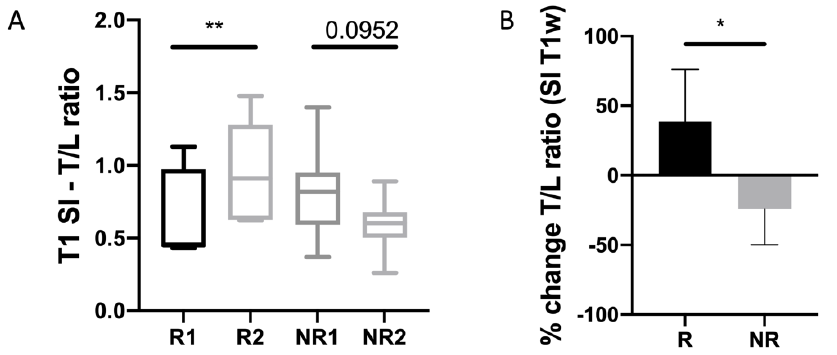
Figure 6. ( A ) T/L ratio of non-enhanced T1w of NELM on baseline and first FU. ( B ) Percentual change of T/L ratio. Asterisks indicate statistical significance (* p ≤ 0.05, ** p ≤ 0.01).